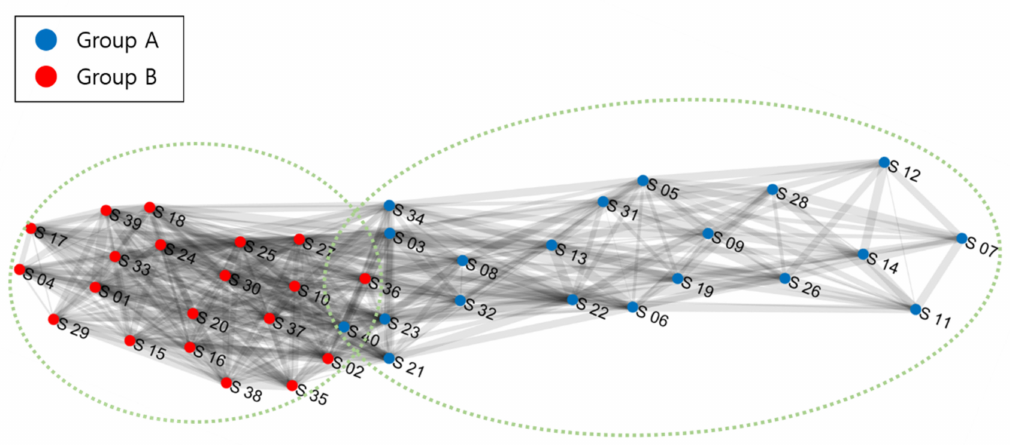
Figure 8. Network graph for the feature “Mean